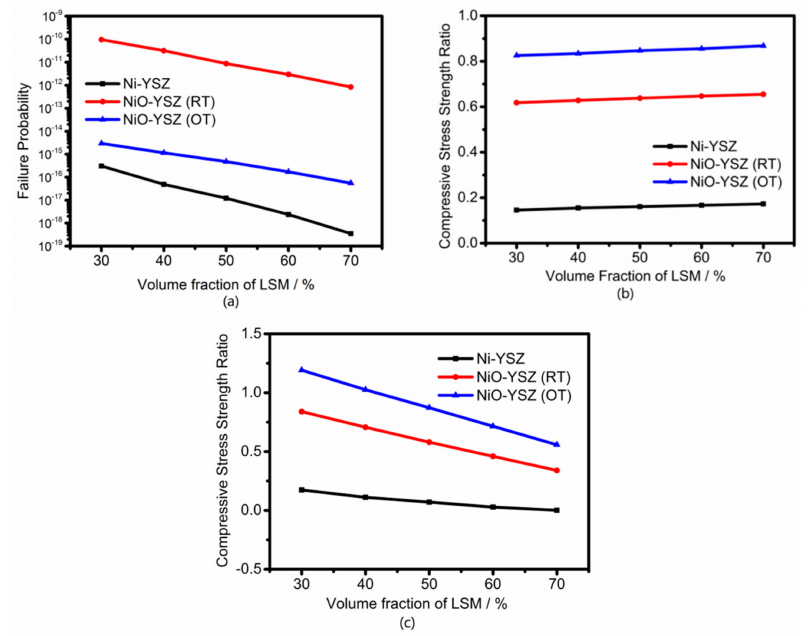
Figure 4. Effects of volume fraction of LSM on the mechanical stabilities of SOFC components: ( a ) the failure probability of anode; ( b ) the compressive stress strength ratio of electrolyte; ( c ) the compressive stress strength ratio of cathode. Results for the Ni-YSZ anode at OT, the NiO-YSZ anode at RT and at OT are shown in black, red, and blue,